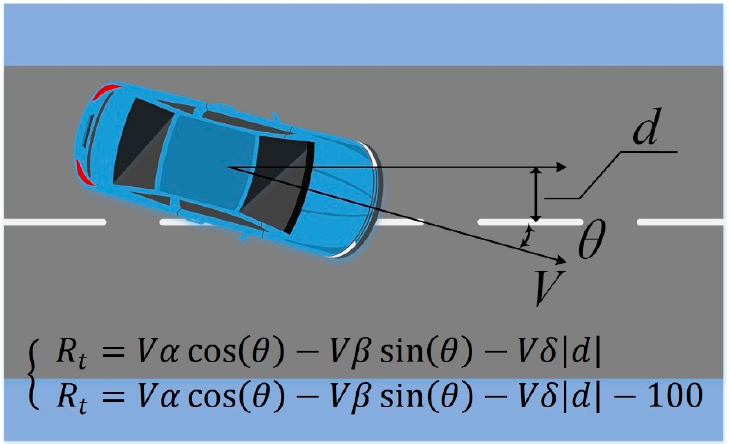
Figure 3. Reward function setting diagram.